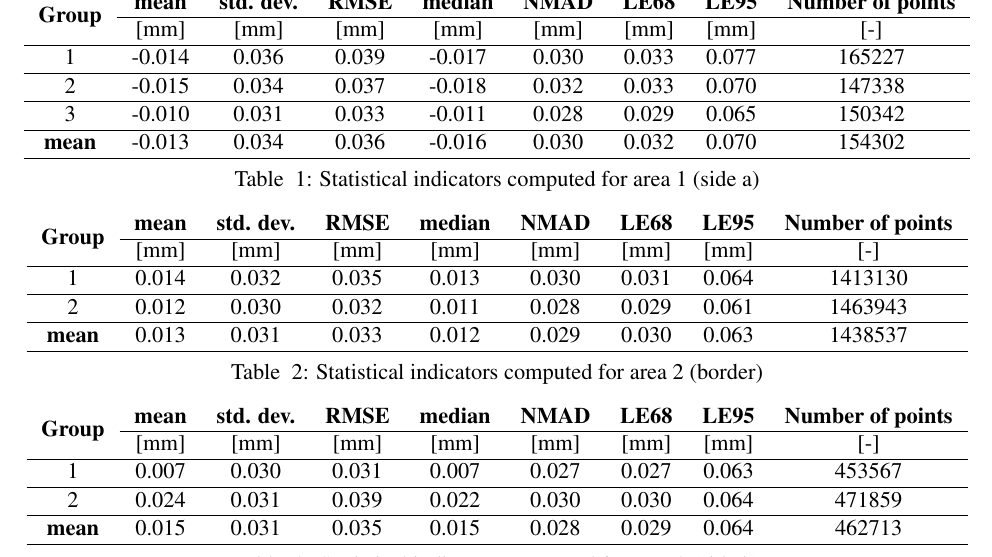
Table 3: Statistical indicators computed for area 3 (side b)